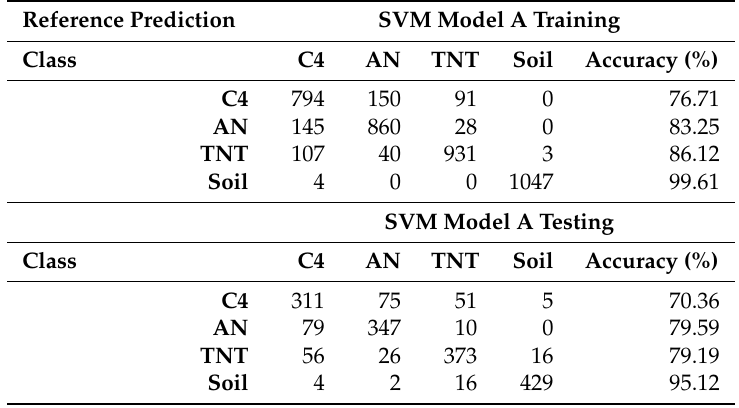
Table 4. Classification results of SVM model